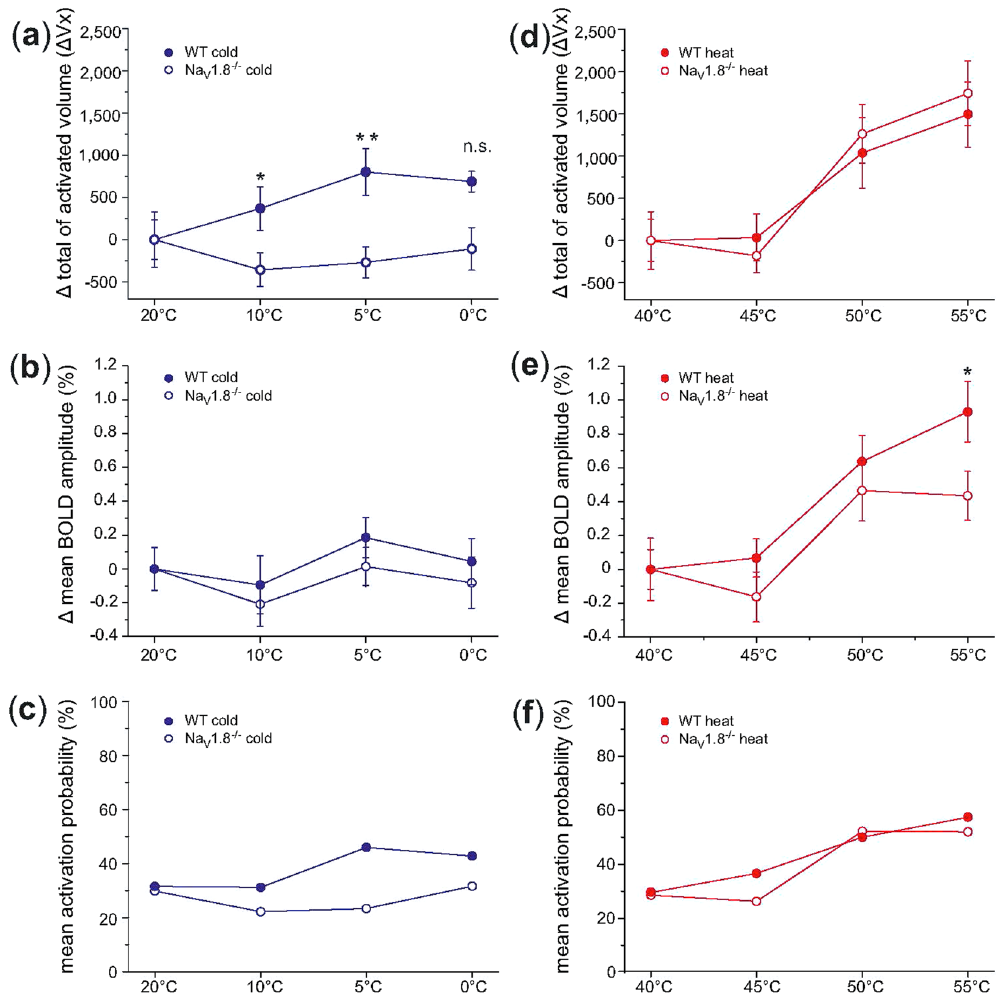
Figure 2. Brain-wide quantification of activated volume, mean BOLD amplitude changes and mean activation probability upon cold and heat stimulation conditions for Na V 1.8 − / − and WT mice. Stimulus-response curves were calculated from the functional data set of both genotypes (WT: • , Na V 1.8 − / − : ⚬ ) and both stimulation conditions (cold: blue, 20 °C to 0 °C and heat: red, 40 °C to 55 °C) for average activated volumes (Vx stands for Voxel) (cold: ( a ), heat: ( d )), mean BOLD amplitudes (cold: ( b ), heat: ( e )) and mean activation probabilities (cold: ( c ) and heat:( f )). Data are presented as mean values across animals and all brain structures for each stimulation temperature referenced to 20 °C as baseline in case of cold stimulation and non-noxious 40 °C in case of heat stimulation, respectively. Brain structures, which were not significantly activated, were included with 0 in the averaging process, which leads to the low mean activation probabilities. Data are presented as mean values ± SEM, n = 10 for WT and Na V 1.8 − / − , respectively. Significant differences between Na V 1.8 − / − and WT mice for each stimulation condition are marked with asterisks: ** p ≤ 0.01; * p ≤ 0.05; n.s. not significant; Student’s t-test, two-sample; multiple comparison correction with α ≤